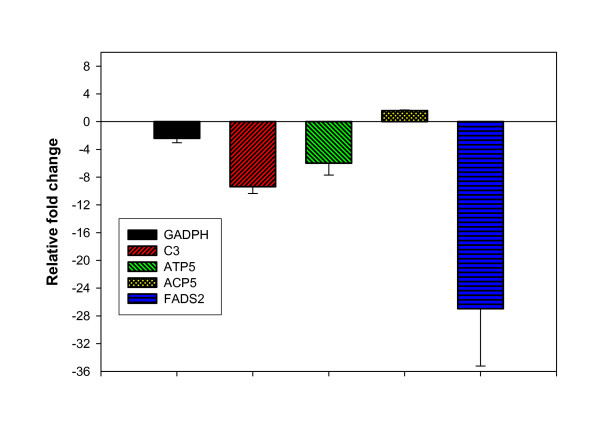
Quantitative real-time PCR confirmation of differential expression for 5 randomly selected genes identified by microarray as differentially expressed (Means ± S.E., n = 6, P < 0.05). The expression trends for all 5 genes were similar in both microarray and real-time PCR analyses. The average fold changes detected by microarray for GADPH, C3, ATP5, ACP5 and FADS2 were -2.9, -2.7, -5.0, 5.7, and -9.5, respectively.